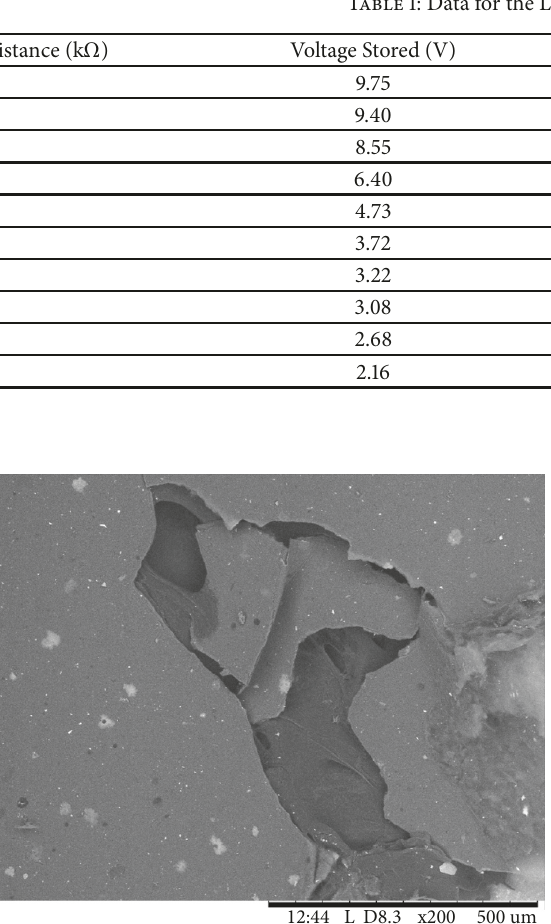
Figure 12: This image shows the edge of a sample of 5 LightScribe reduction cycle graphene oxide taken using the SHOCON contact probe. Thethree-dimensionaltopographyandedgepositioningofthesampleallowforanapproximationofthenumberoflayersofstackedgraphene. This sample contains 4-5 layers seen in the various height differentials. Table 1: Data for the LightScribe graphene capacitor.